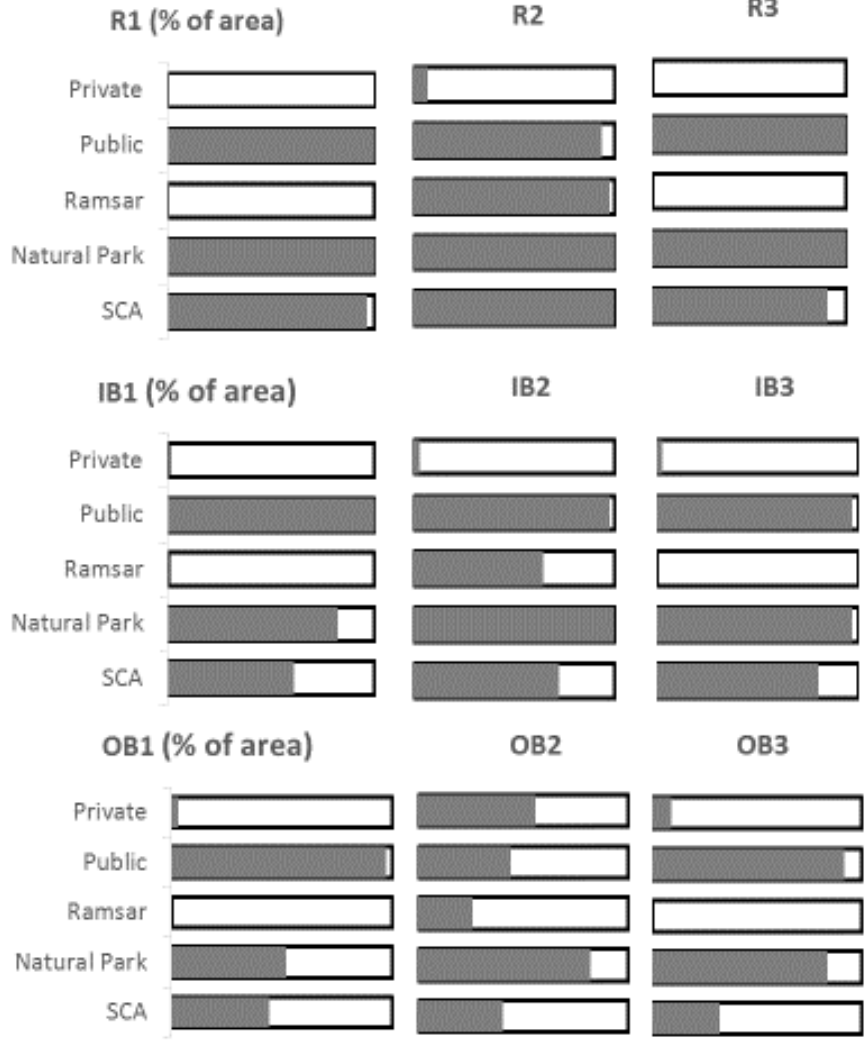
Figure 8. Spatial analysis of the reserve (R), inner buffer (IB) and outer buffer (OB) zones in terms of % of area classified as private/public, Ramsar, Natural Park and SCA (Natura 2000 Special Conservation Area).